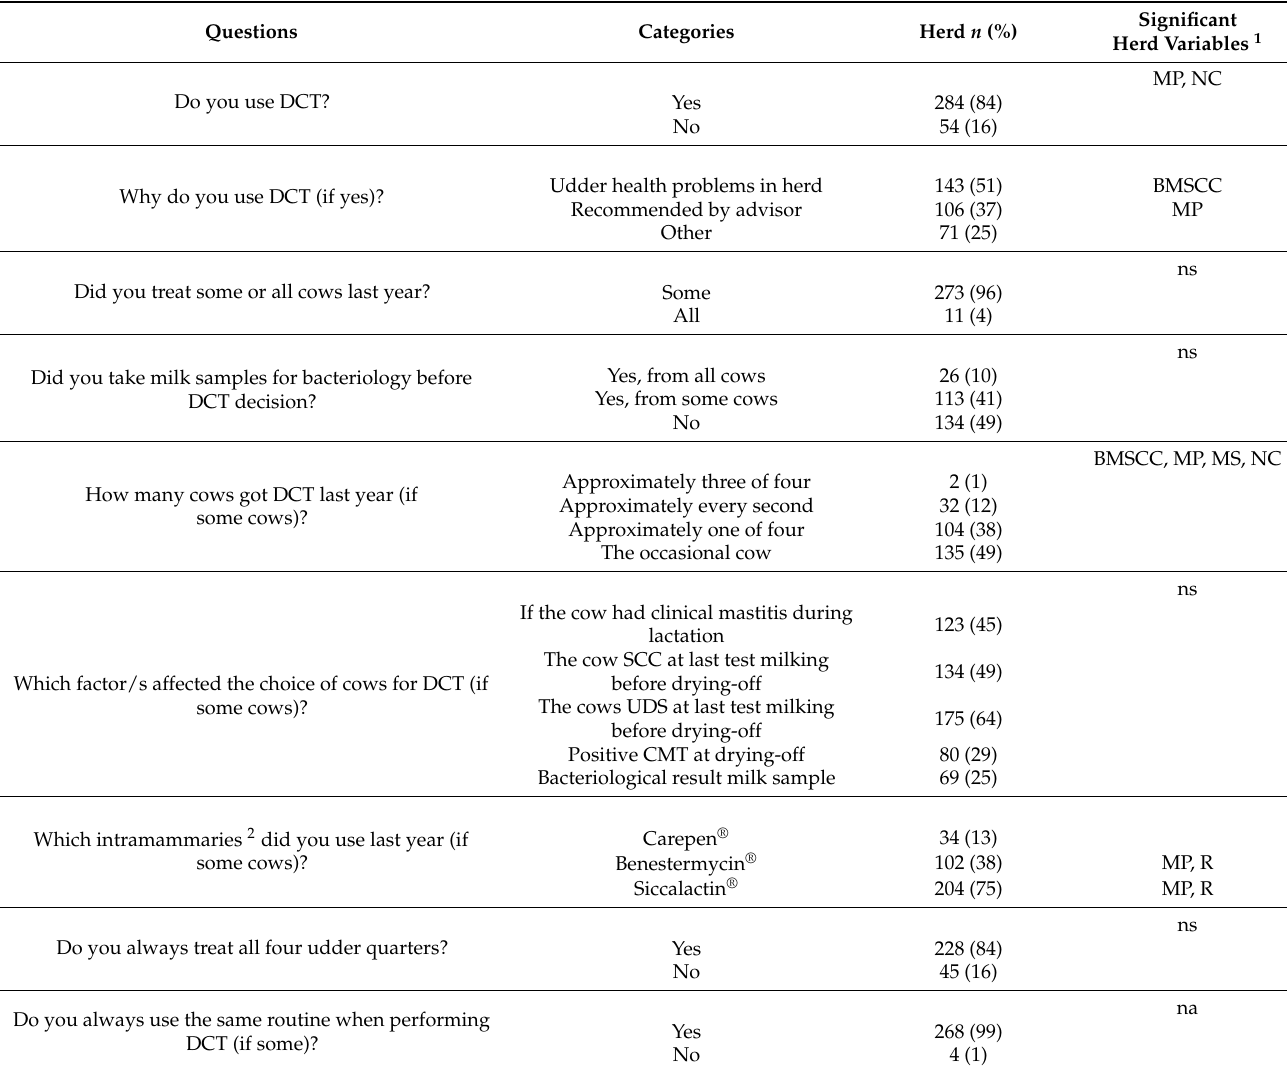
Table 3. Responses to questions about routines regarding dry-cow therapy (DCT) of dairy cows with intramammaries containing antibiotics given by farmers ( n = 340) participating in a web-based questionnaire. The associations between herd variables and the answers were investigated using univariable regression models and if significant ( p ≤ 0.05) the herd variables are